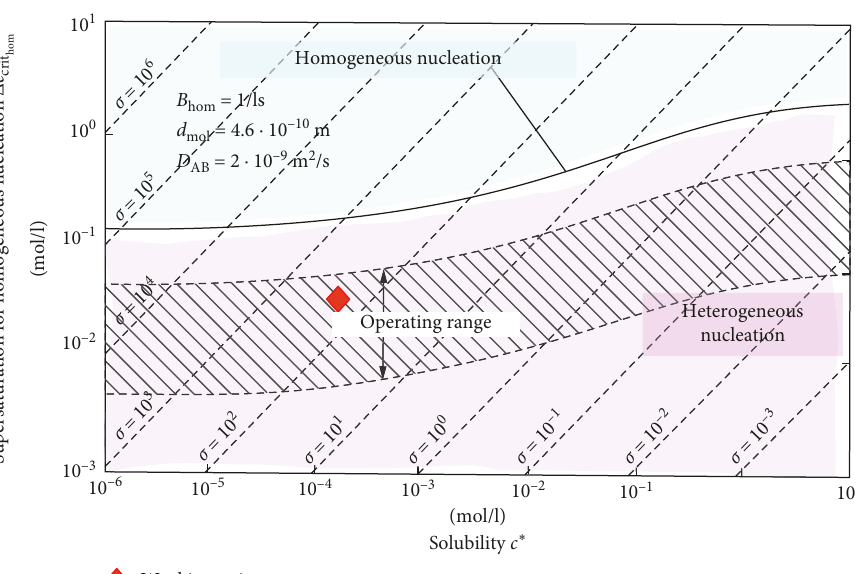
2 precipitation.